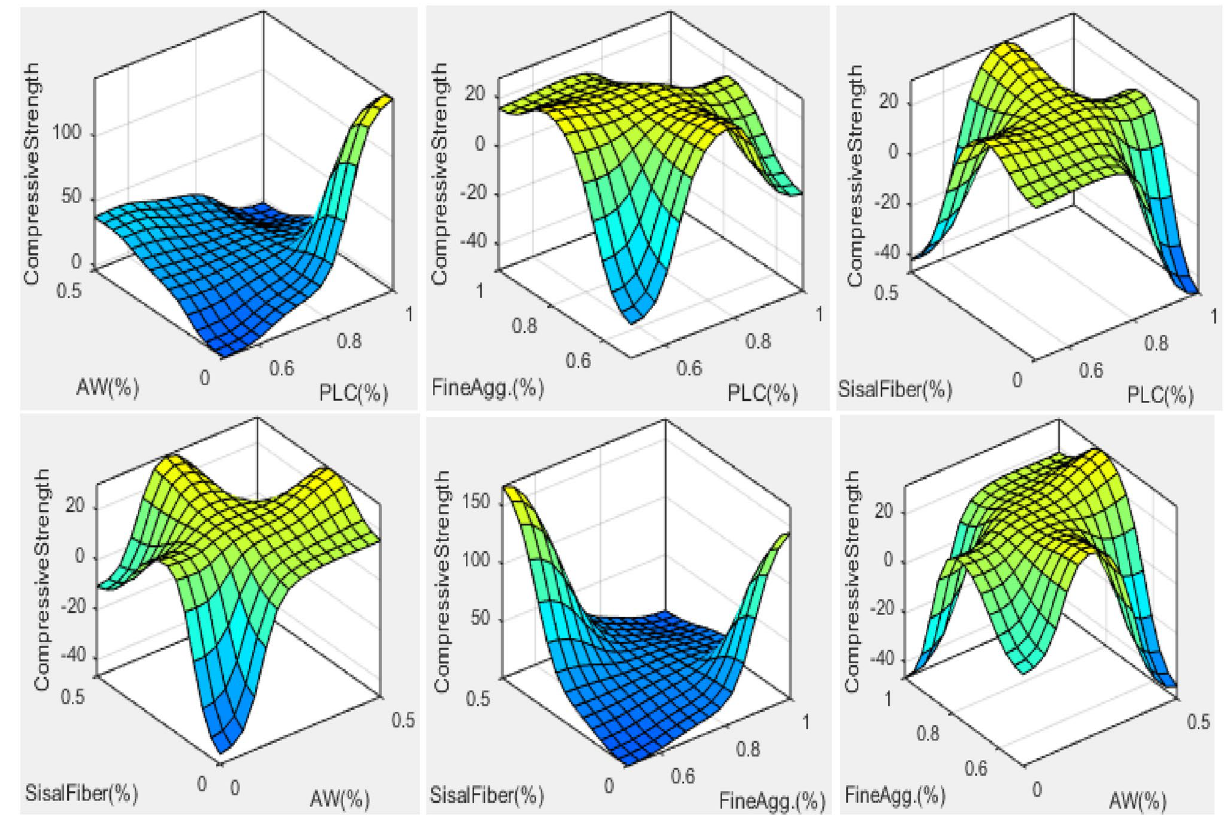
Figure 19. Model variables’ 3D-surface